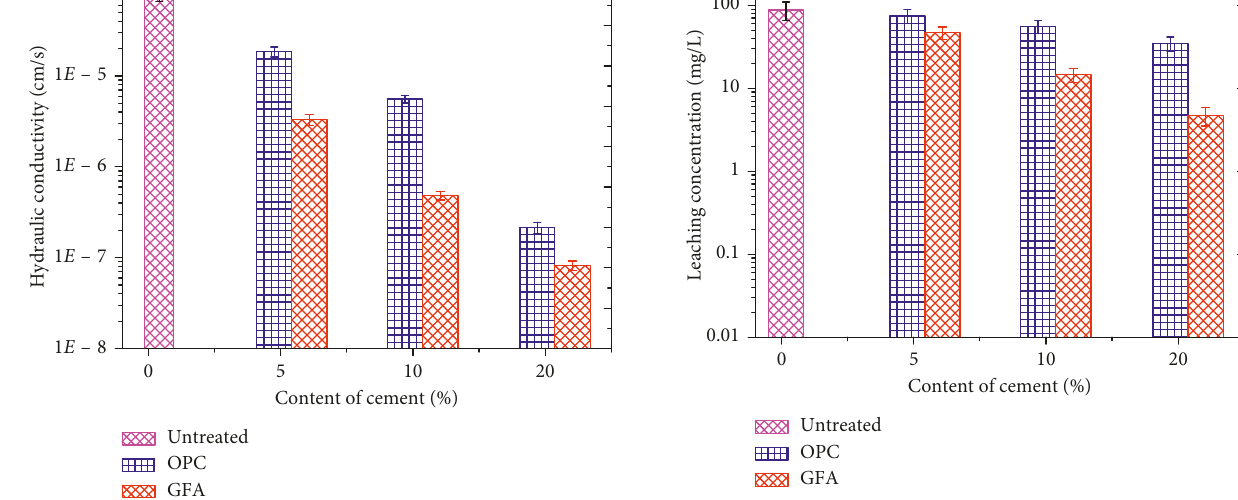
Figure 2: Hydraulic conductivity of solidified/stabilized soils.